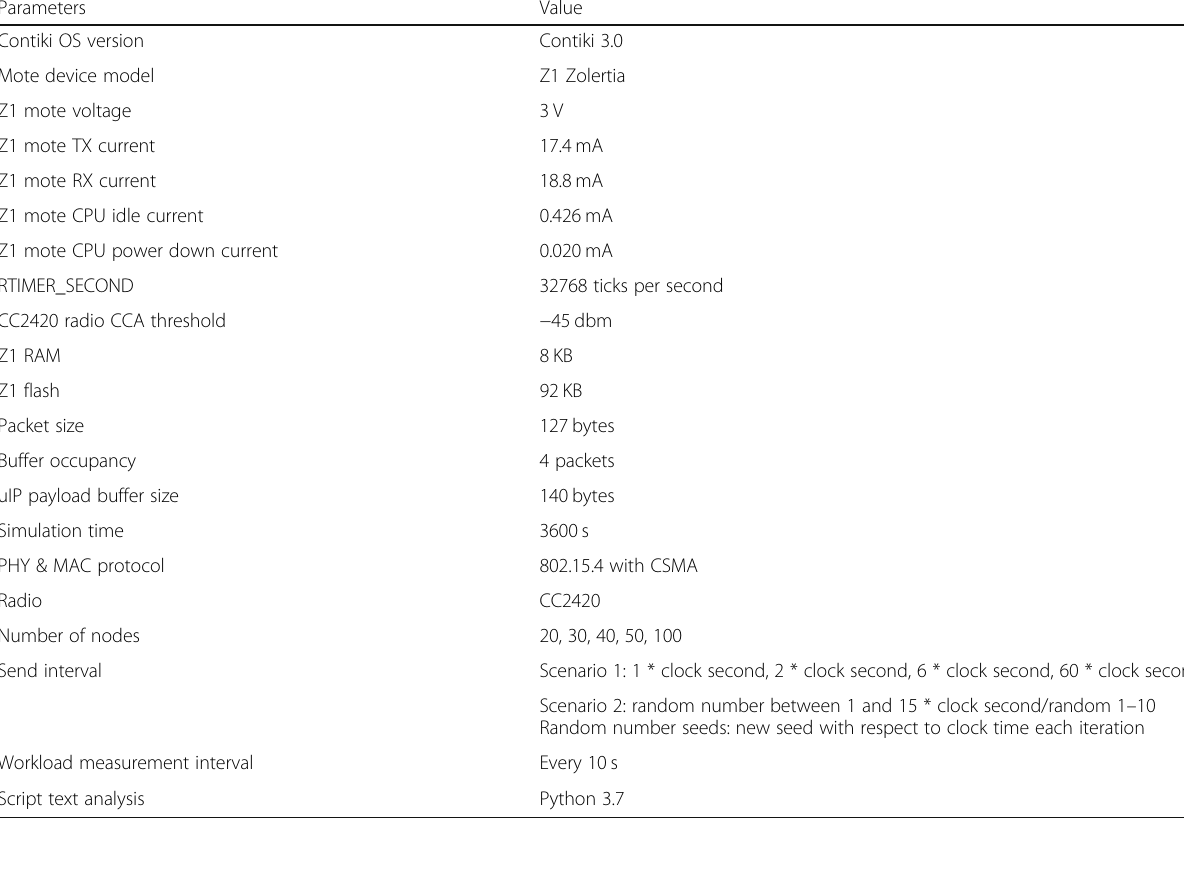
Table 3 Simulation model parameters and their values